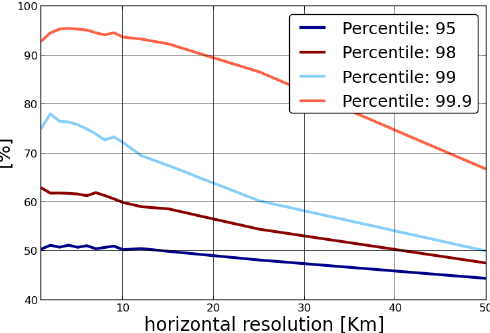
Figure 9. Convective dominance vs. horizontal resolution. The ratio of the number of convective precipitation events with precipitation intensities greater than or equal to the labeled percentile of total pre- cipitation intensities over entire Germany for the years 2007–2008. The data are aggregated to 5min temporal and different horizontal